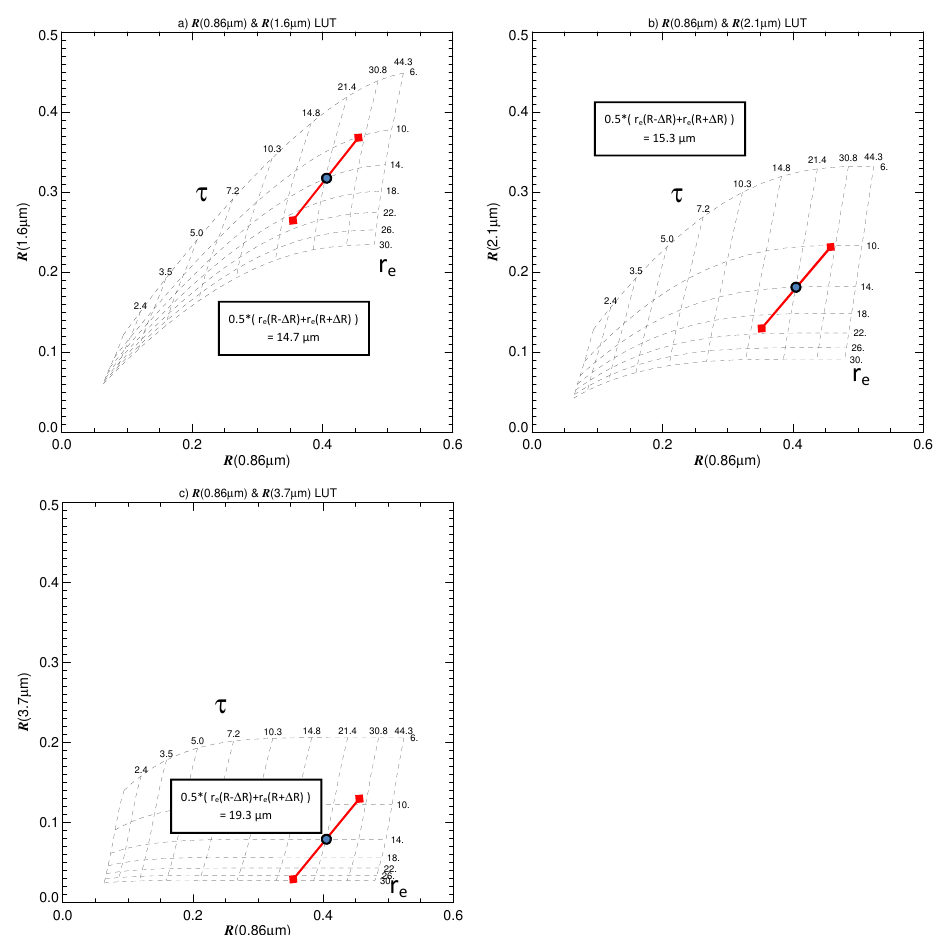
Figure 17. An example of the effect of 3-D effects on MODIS retrievals at small averaging scales. 3-D effects at high θ 0 are assumed to cause an equal increase and decrease ( 1R ) in the reflectances of both the absorbing band ( R ab ) and the non-absorbing band ( R nab ). For this demonstration it is assumed that there are an equal number of small-scale cloud elements all with r e = 14µm and τ = 23 . 6. Retrievals are then made on the reflectances that have been distorted by the 3-D effects using MODIS lookup tables (LUTs) that are used for converting non-absorbing (0.86µm) and absorbing reflectance pairs into τ and r e . These are shown for θ 0 = 79 ◦ and a nadir viewing angle: (a) is for the 1.6µm absorbing band, (b) for 2.1µm and (c) for 3.7µm. It can be seen that in all cases the retrieved r e would be greater than the true r e of 14µm. See Sect. 5.1 for further